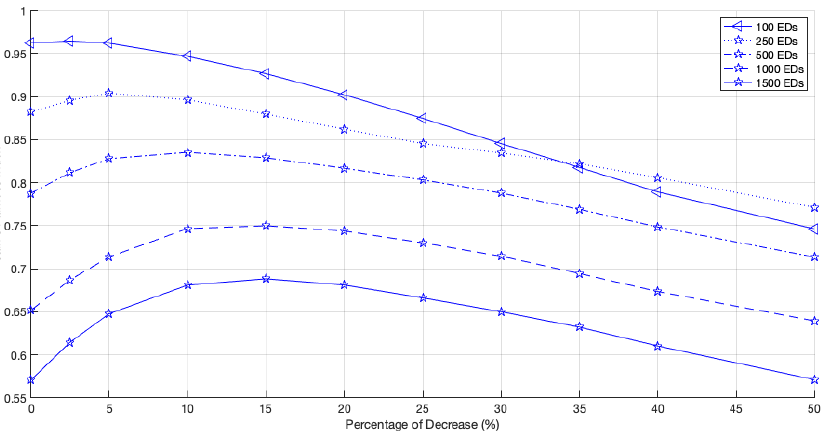
Figure 12. Network fairness for 2 GWs, different network sizes and different PoD.